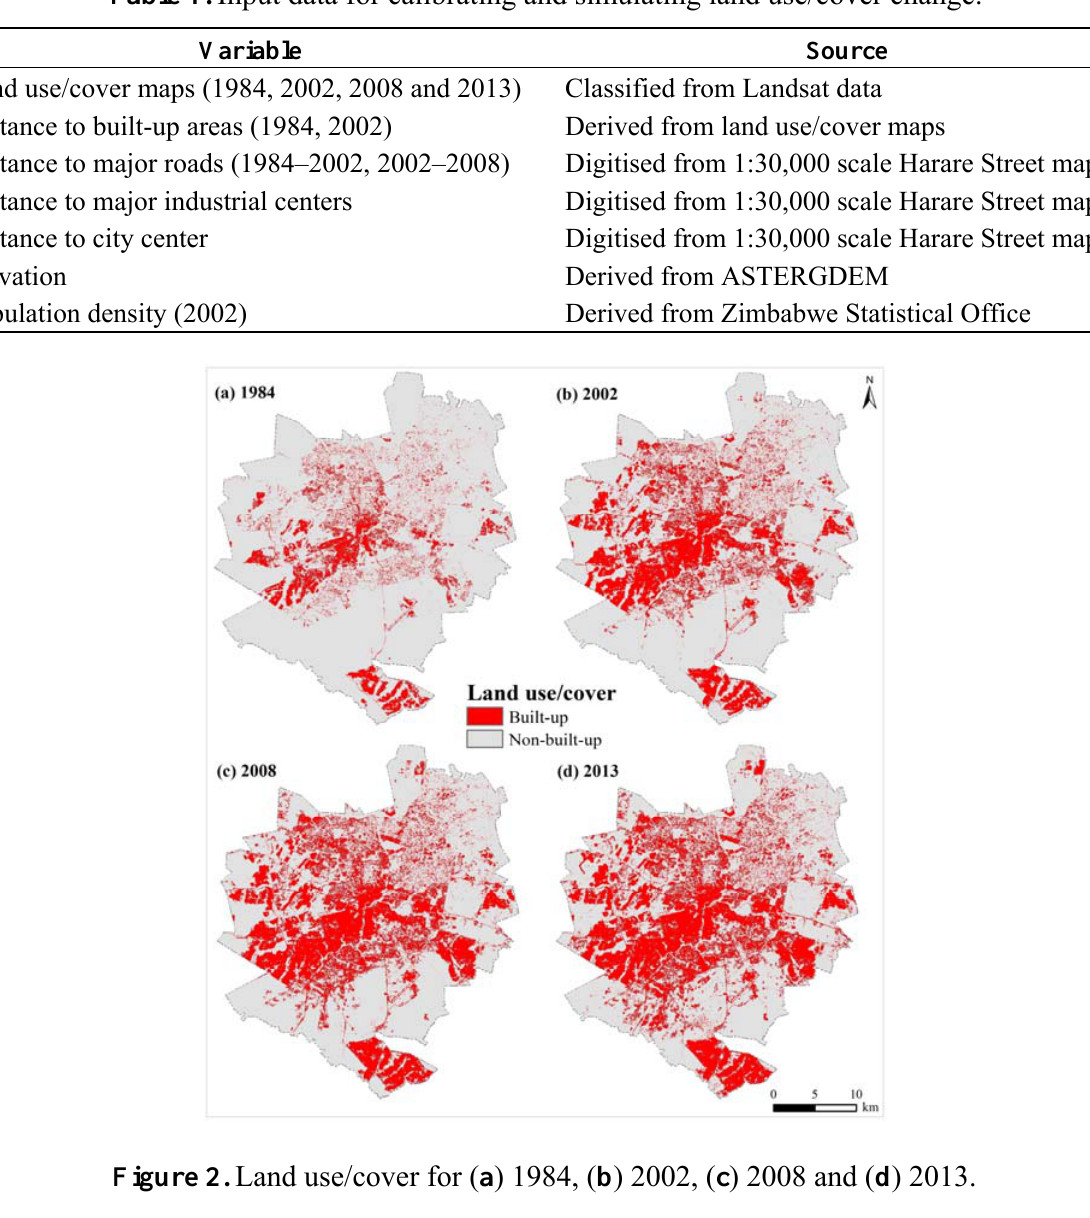
Table 1. Input data for calibrating and simulating land use/cover change.